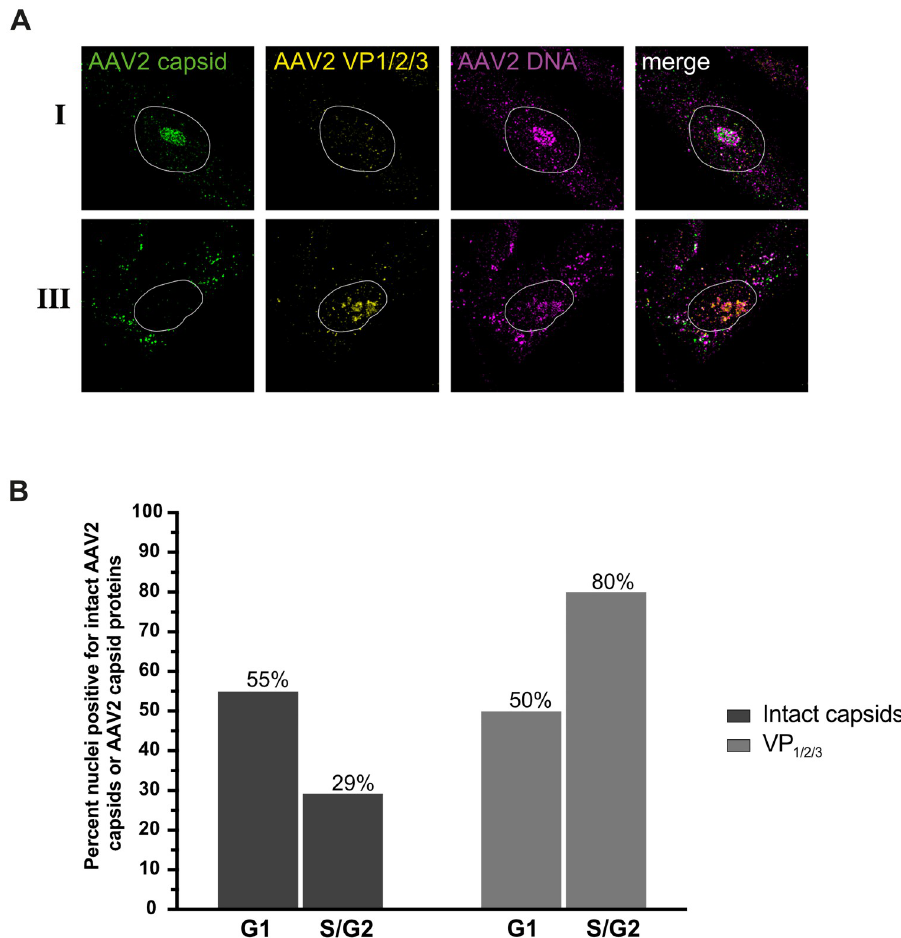
Fig 10. Capsid disassembly coincides with cell cycle progression. NHF cells were infected with wtAAV2 (MOI 20‘000). At 24 hpi, the cells were fixed and processed for multicolor IF analysis combined with FISH and CLSM. (A) Intact capsids (green) or capsid proteins (yellow) were detected using either an antibody against intact AAV2 capsids (conformational capsid epitope) or an antibody (linear epitope) against VP1, VP2 and VP3. AAV2 DNA (magenta) was detected with an Alexa Fluor (AF) 647 labeled, amine-modified DNA probe that binds to the AAV2 genome. Nuclei were counterstained with DAPI and illustrated as white lines. The cells shown were assigned as pattern I and III according to the intensity of the capsid staining and following a similar classification as defined in Fig 4. (B) Quantification of at least 70 nuclei positive for intact AAV2 capsids or capsid proteins during cell cycle